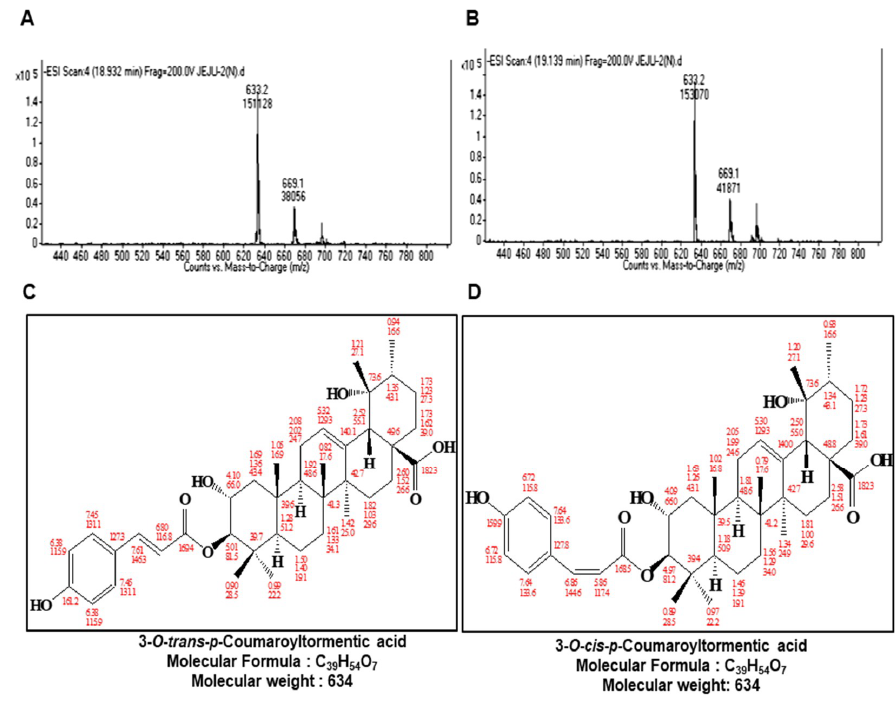
Figure 2. Molecular structure of the CSC inhibitor isolated from aronia. ( A , B ) Molecular mass of the CSC inhibitor derived from aronia based on electrospray ionization (ESI) mass spectrometry. ( C,D ) Molecular structure of 3 - O - trans - p -coumaroyltormentic acid and 3 - O - cis - p -coumaroyltormentic acid. 2.3. 3-O-p-Coumaroyltormentic Acid Inhibits Breast Cancer Cell Proliferation and Mammosphere Formation